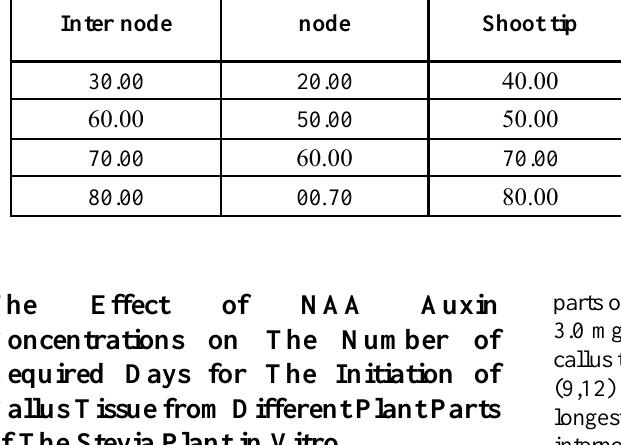
Table 5. The effect of NAA auxin concentrations on the number required days for the initiation of callus tissue from different plant parts of the stevia plant in vitro